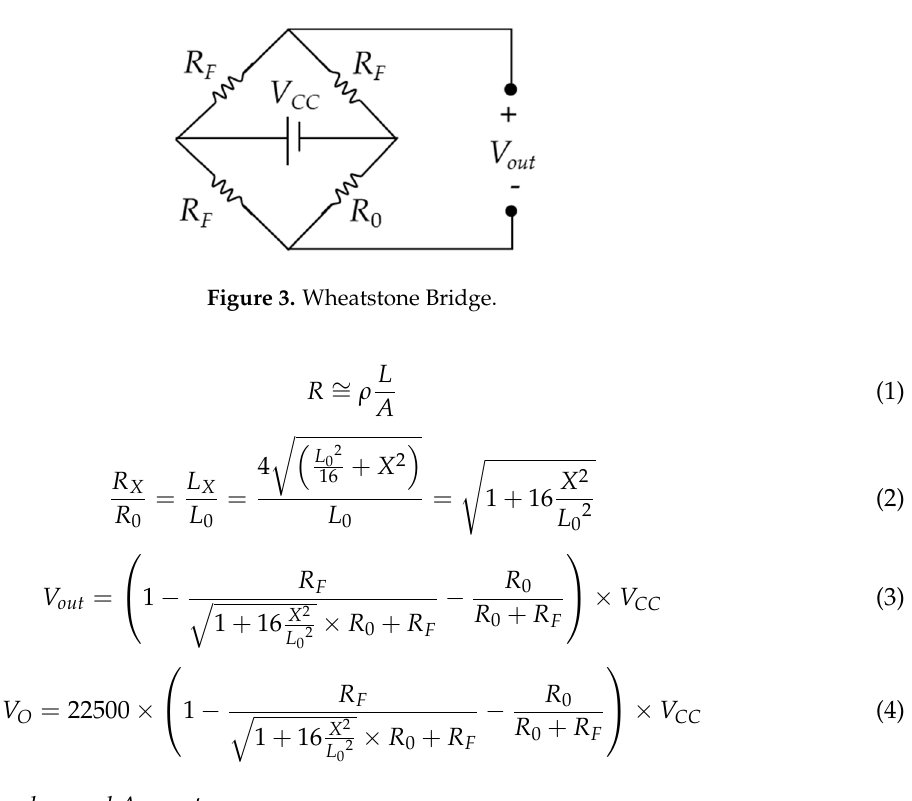
Figure 2. Strained wire length and deformation amount.